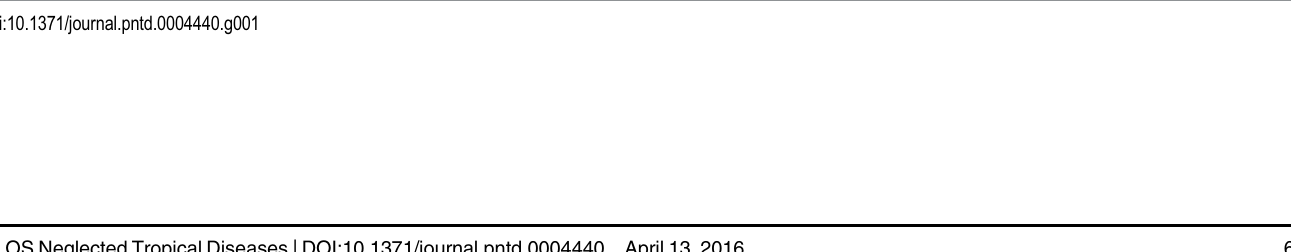
Fig 1. Maximum-likelihood phylogenetic placement (FastTree2) of El Huayo virus (Segment L). Strains colored in blue represent Group C orthobunyavirus genomes. Nodes with low bootstrap support (less than 0.8, Shimodaira- Hasegawa) are colored red. The strain in bold and indicated by the arrow indicates El Huayo virus, the novel strain sequenced in this